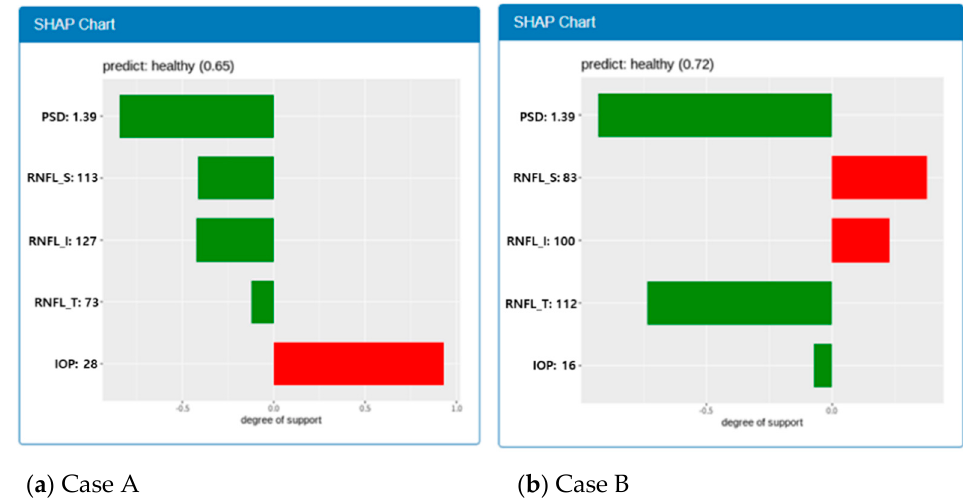
Figure 8. SHAP chart that shows feature interaction. The same PSD value of 1.39 has different weights in case A and case B.